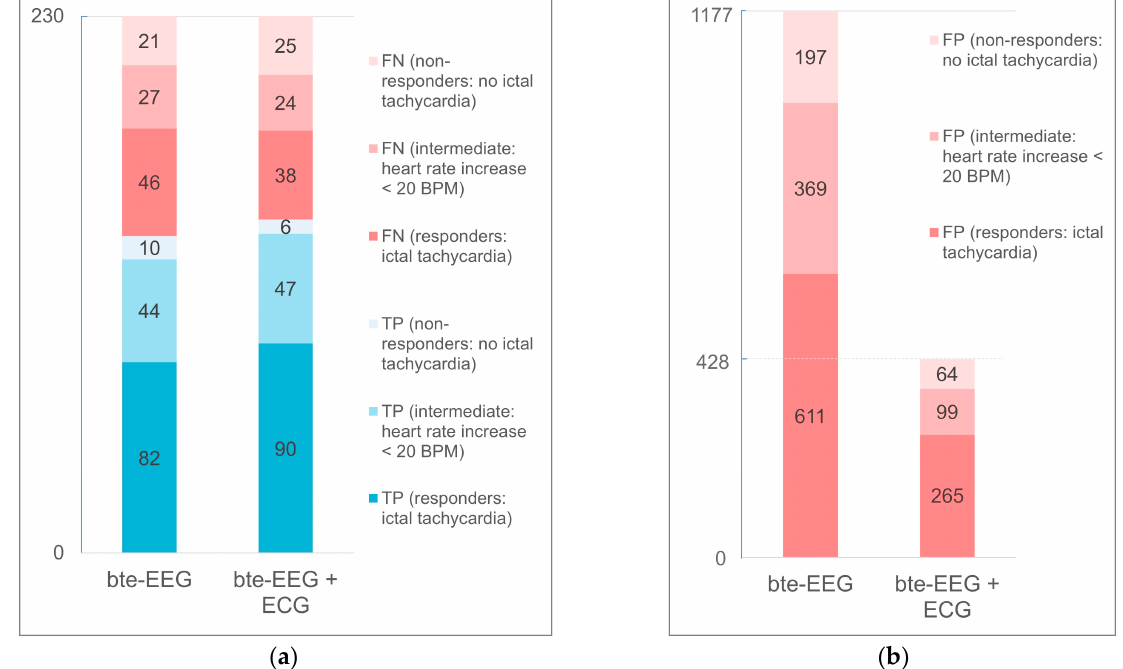
Figure 5. ( a ) Number of true positives (TP, correctly annotated seizures) and false negatives (FN, mislabeled seizure segments) and ( b ) number of false positives (FP, detections incorrectly classified as seizures) of the two readers in the two experimental setups readers discriminated by the type of patient (responder, non-responder, or intermediate response) according to the presence of ictal ECG changes.